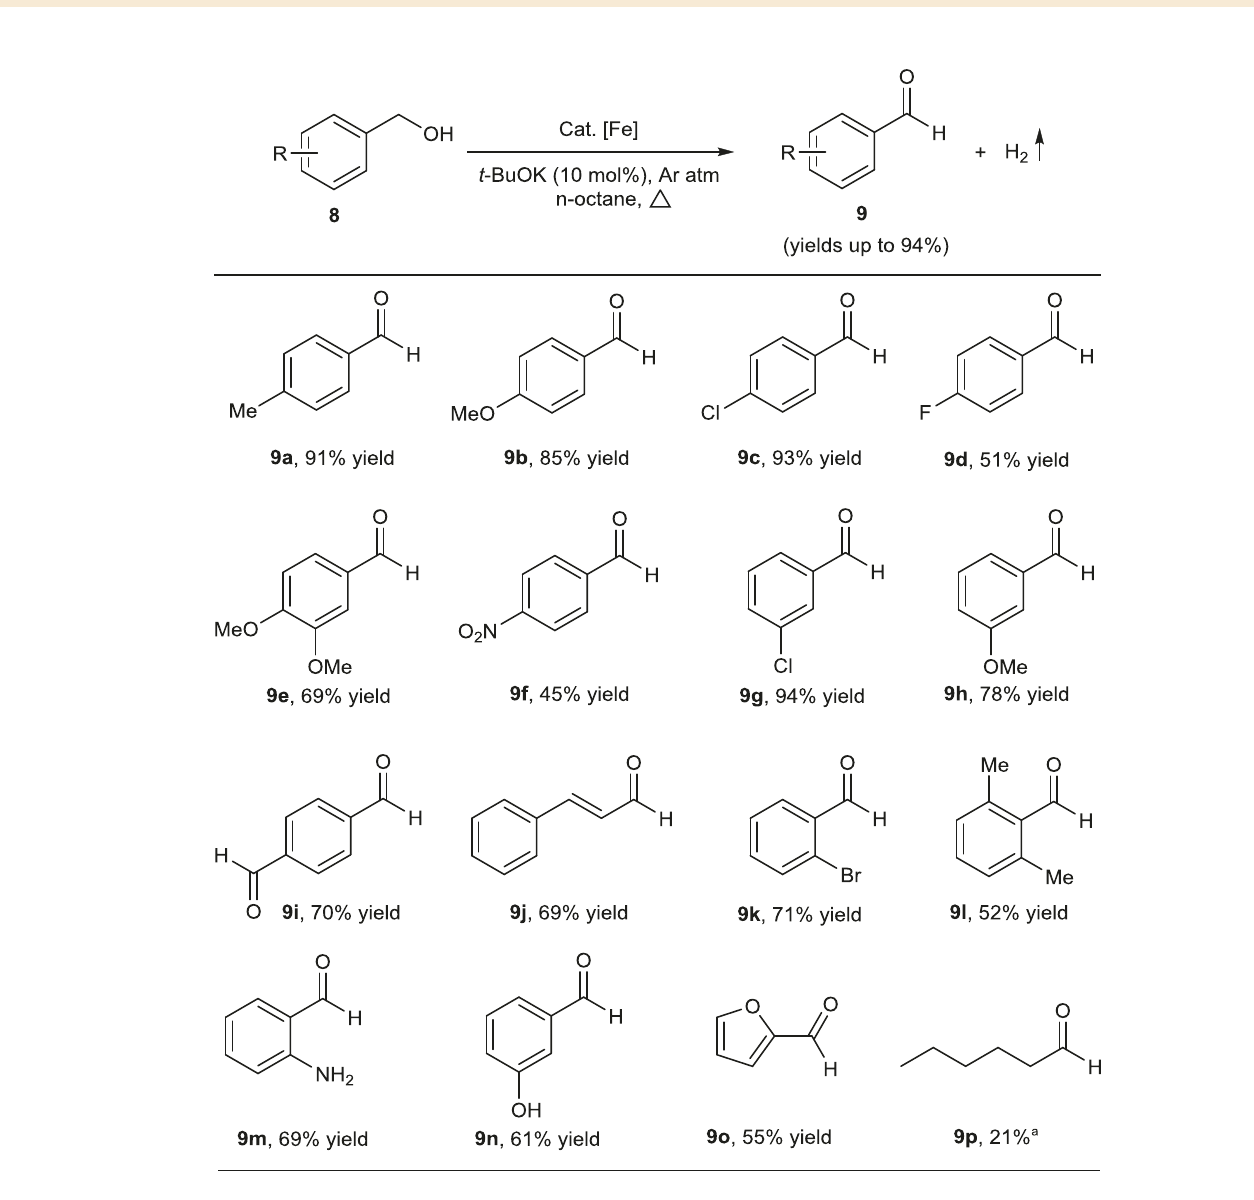
Table 4 Nanoscale iron-catalyzed acceptorless dehydrogenation of primary